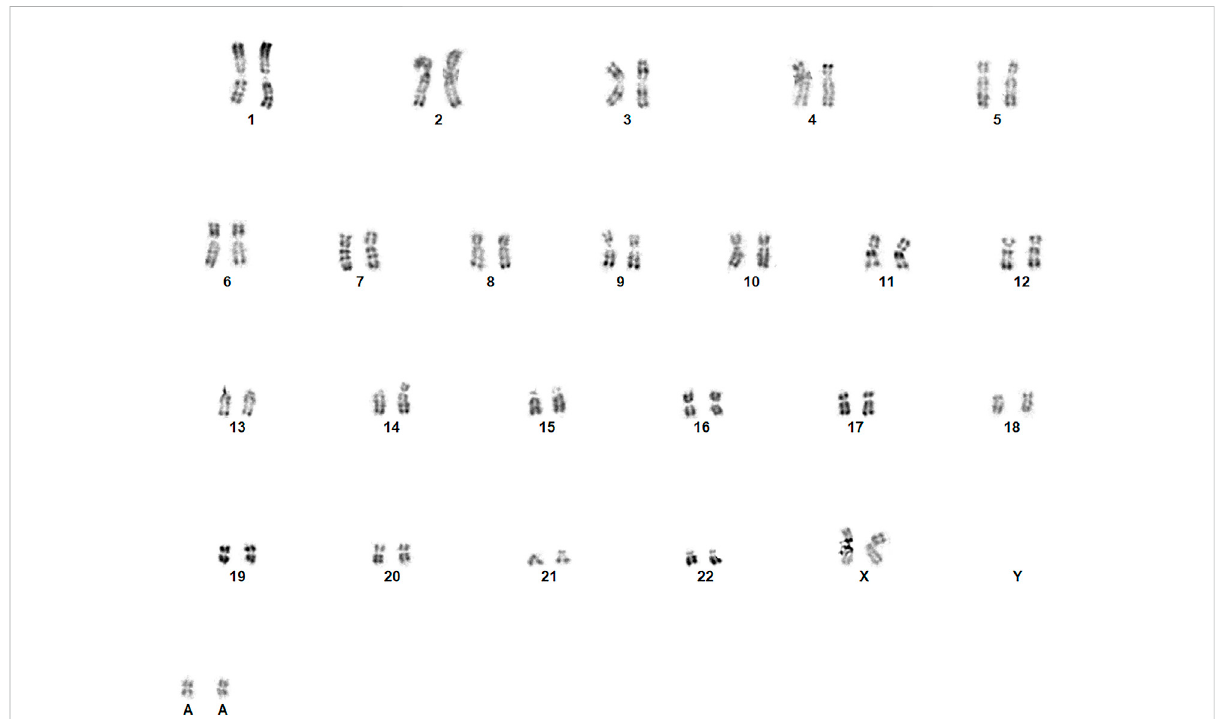
FIGURE 1 Identi fi cation of the marker chromosomes with direct examination of the cytotrophoblast following CVS [revealed two supplementary and identical SMCs (48,XX,+marx2)].